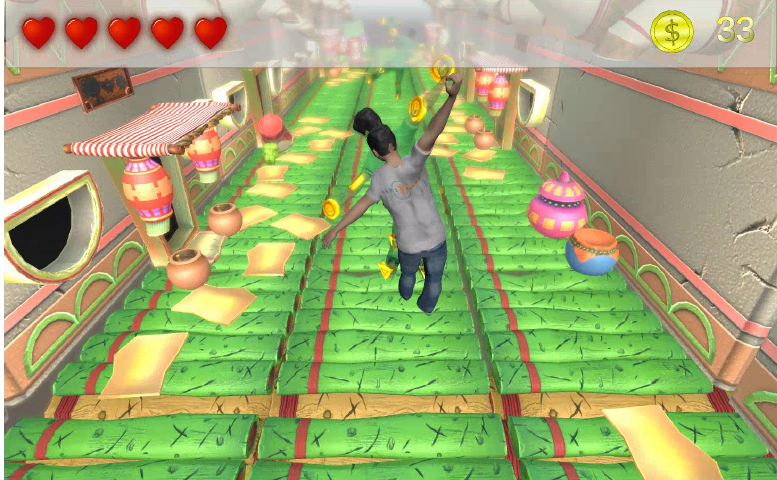
Figure 7. Screenshot of the gaming environment showing the patient character and the virtual assistant with different postures to be